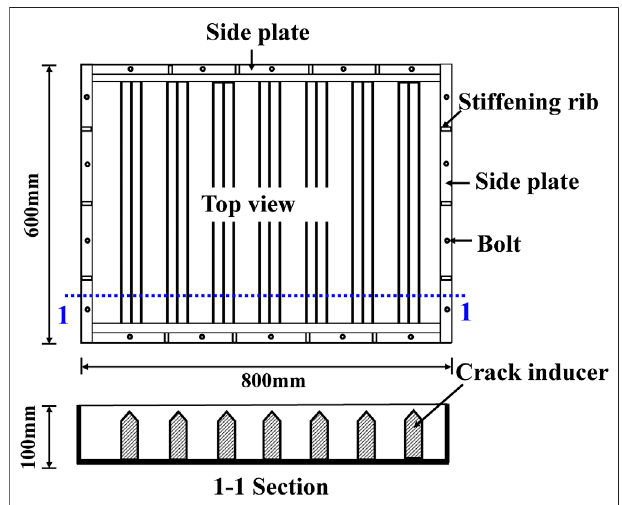
FIGURE 1 | Schematic diagram of slab cracking frame